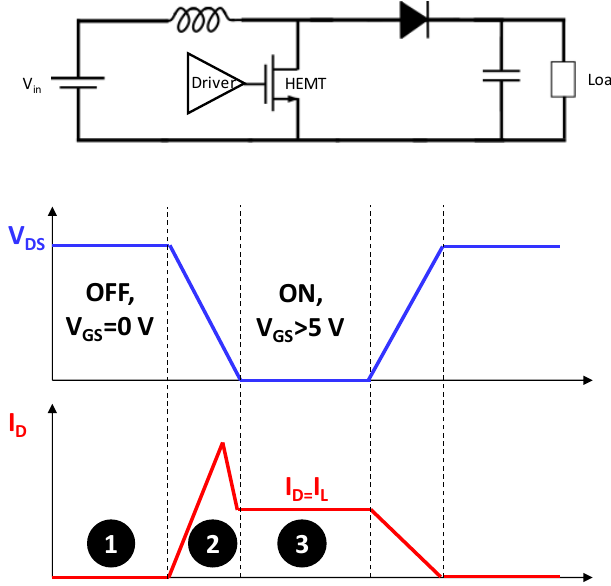
Figure 1. Schematic representation of a boost power converter and of the switching transitions during operation.